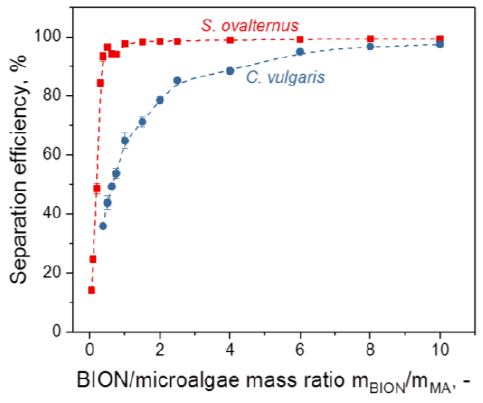
Figure 3. Separation efficiency of S. ovalternus und C. vulgaris at pH 4 for nanoparticle-to-microalgae mass ratios in the range 0.05–10 g/g.